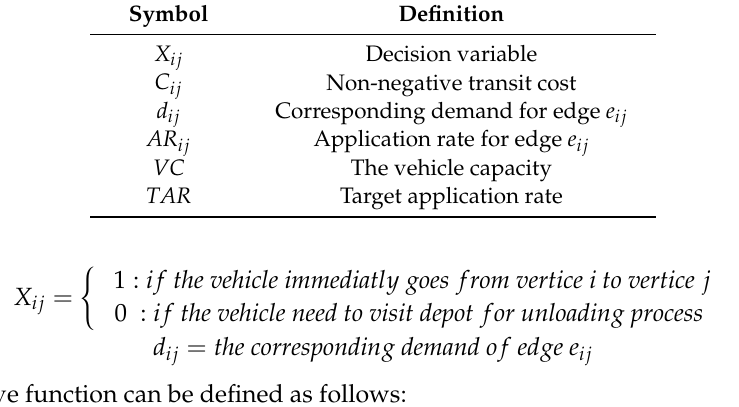
Table 1. Definition of the symbols that presented in the mathematical formulation of the problem.